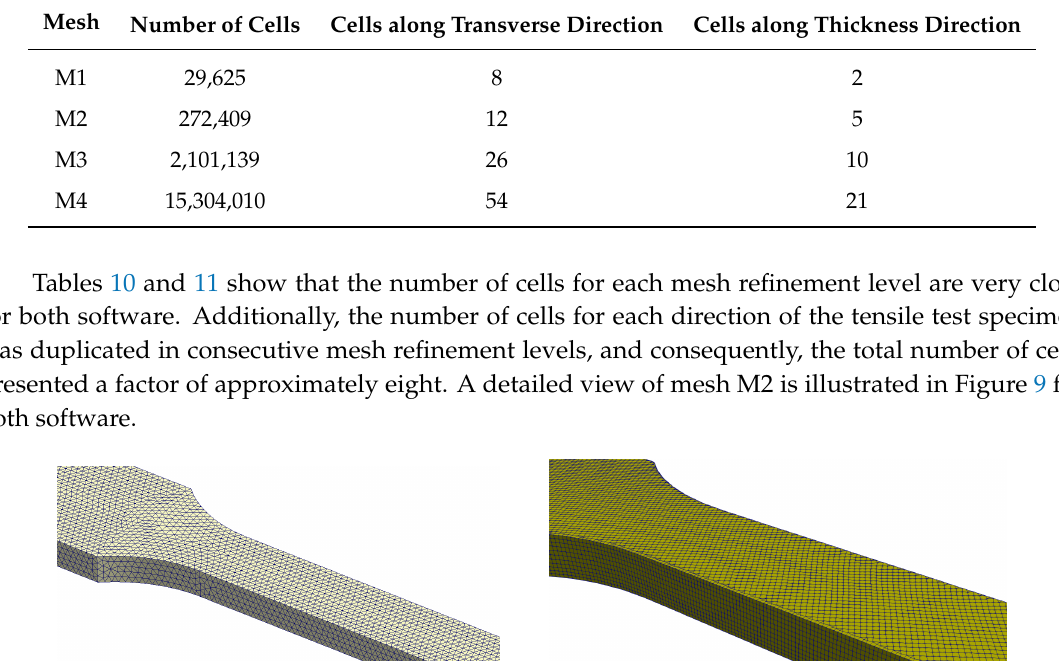
Figure 9. Mesh M2 for Moldex 3 D R